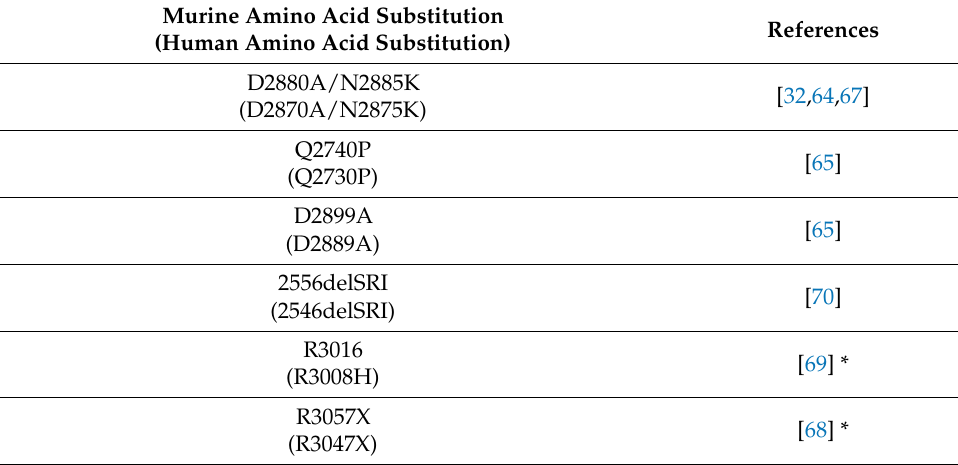
Table 3. ATM kinase dead amino acid substitution modeled in